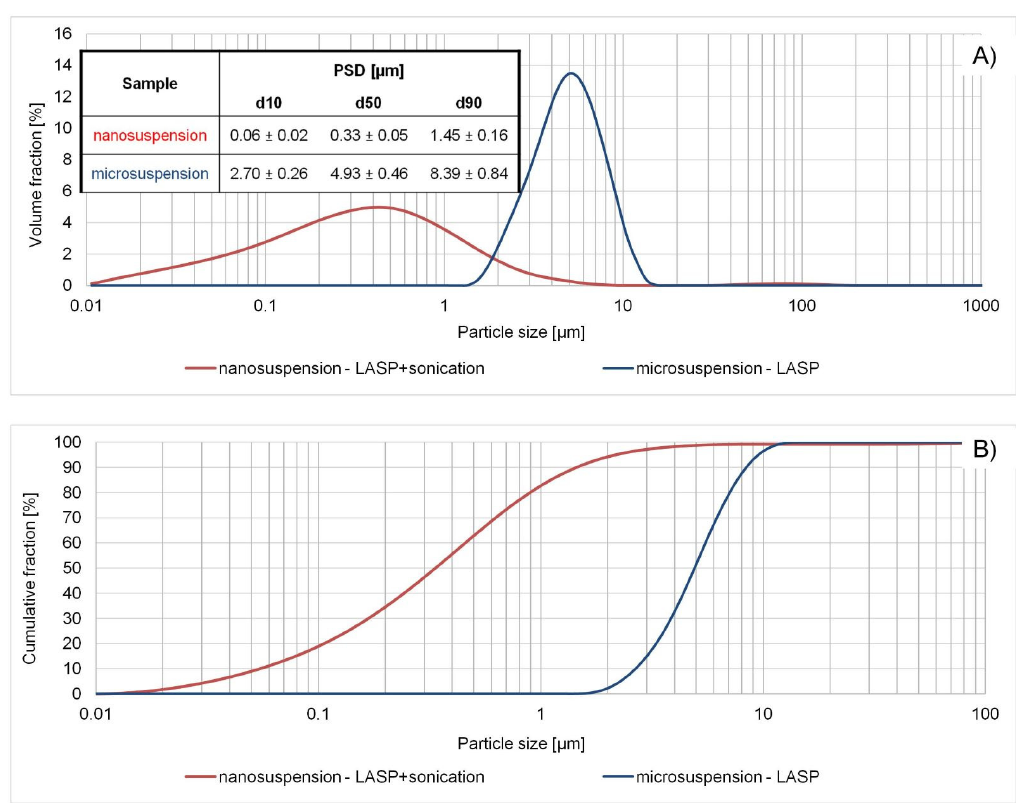
Figure 8. Comparison of particle size distributions (( A ) frequency distribution, ( B ) cumulative distribution) of optimized cilostazol nano- and microsuspensions (mean ± SD, n = 3).